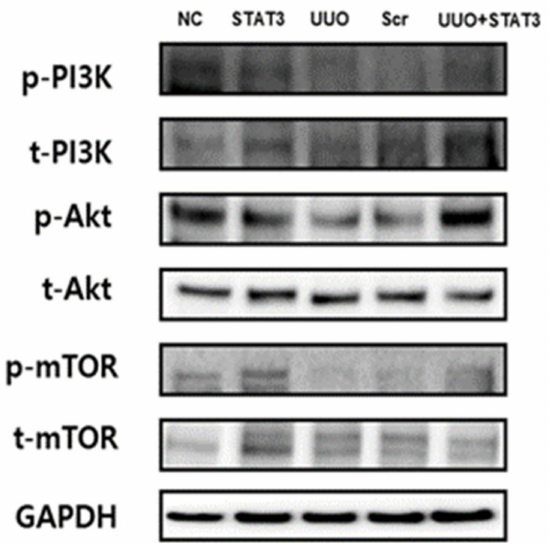
Figure 6. Induction of the PI3K-Akt-mTOR Pathway in a UUO Mouse Model with STAT3 Decoy ODN Injection. The PI3k-Akt-mTOR signaling pathway was increased in UUO mouse model with STAT3 decoy injection. Western blot data show the PI3K-Akt-mTOR pathway. The expression of p -PI3K, p -Akt, and p -mTOR decrease in UUO and autophagy induces in UUO mouse model. Abbreviations: UUO, unilateral ureteral obstruction; decoy ODNs, decoy oligonucleotides; STAT3, signal transducer and activator of transcription 3; Scr, scrambled; PI3K, phosphoinositide 3-kinase; Akt, protein kinase B; mTOR, mammalian target of